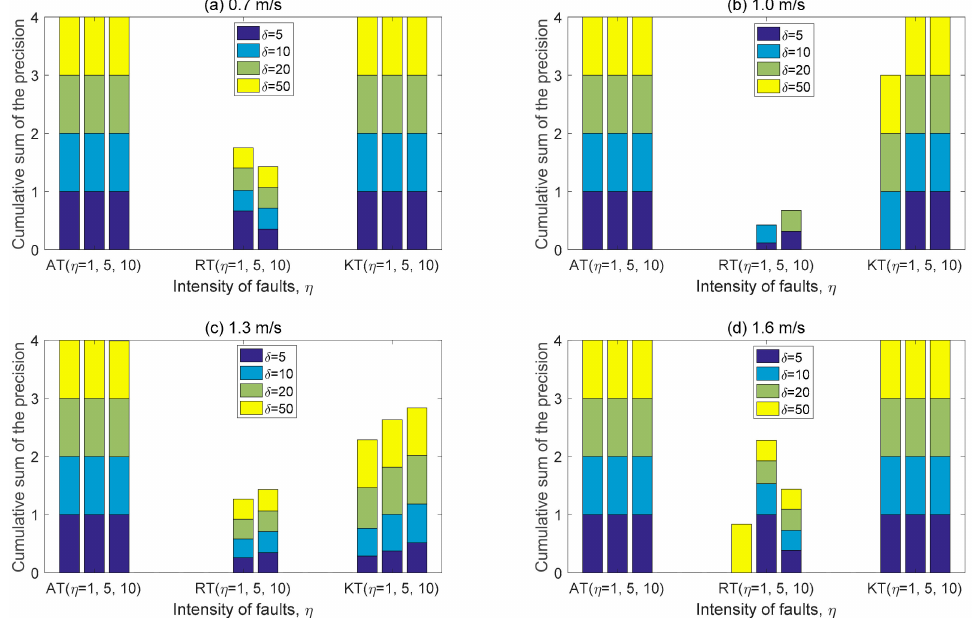
Figure 9. Precision according to each duration as a function of random fault intensity: ( a ) Cumulative sum of the precision at 0.7 m/s of Jackal UGV; ( b ) Cumulative sum of the precision at 1.0 m/s; ( c ) Cumulative sum of the precision at 1.3 m/s; ( d ) Cumulative sum of the precision at 1.6